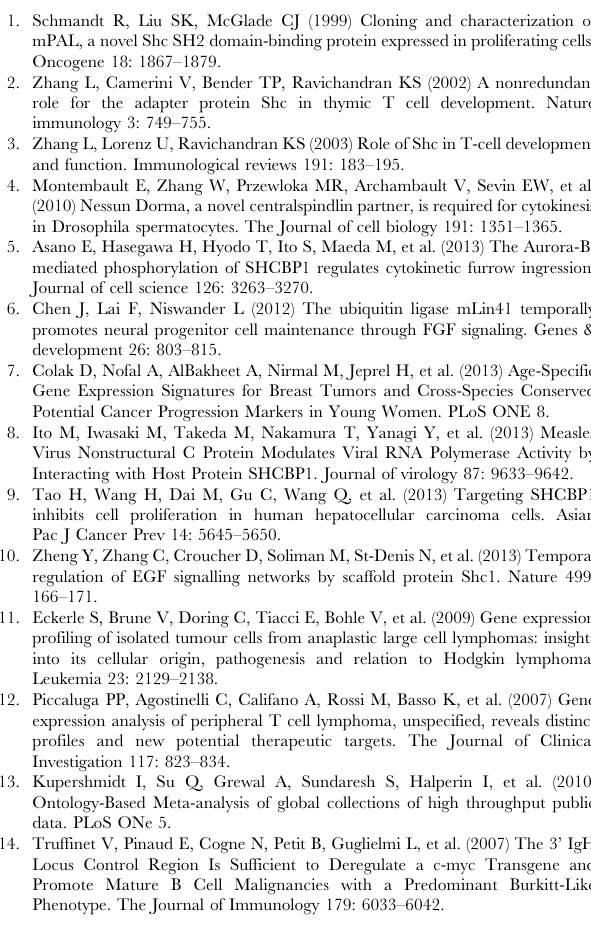
Figure S7 Original images and gels from all figures and supporting files. This supporting figure includes the original images and gels from all figures and supporting files. The images are not altered in any way and are unmodified and not